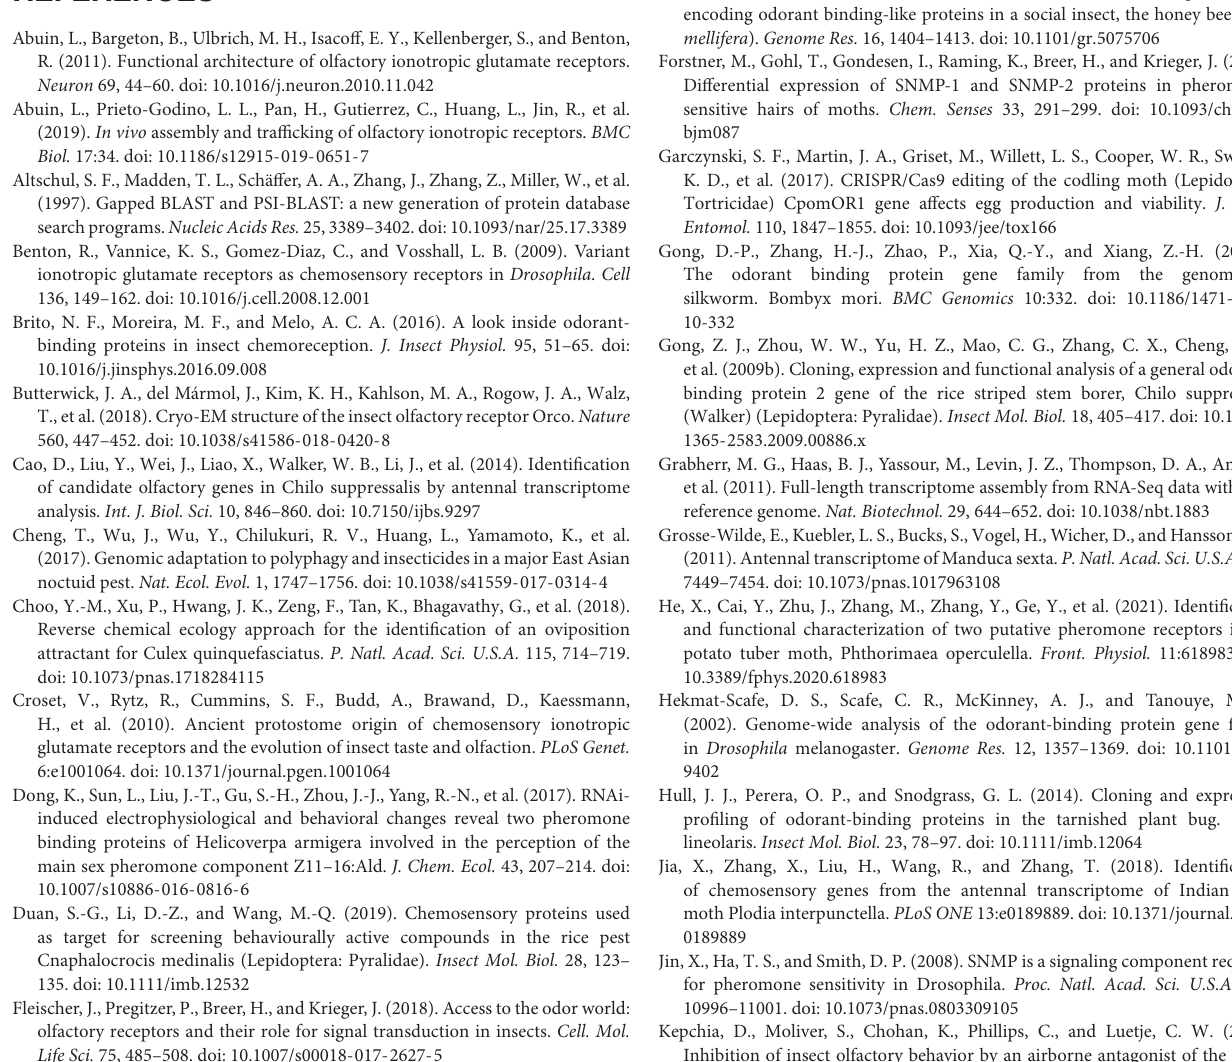
Supplementary Figure 5 | Alignment of the deduced protein sequences of G. mellonella CSPs. Supplementary Figure 6 | Alignment of deduced G. mellonella SNMP protein sequences with orthologs from other insect species. Supplementary Table 1 | Accession numbers of OBPs, CSPs, ORs, IRs, and SNMPs used in phylogenetic analyses. Supplementary Table 2 | Amino acid sequences of OBPs and CSPs used in motif pattern analyses. Supplementary Table 3 | Primers used in this study.